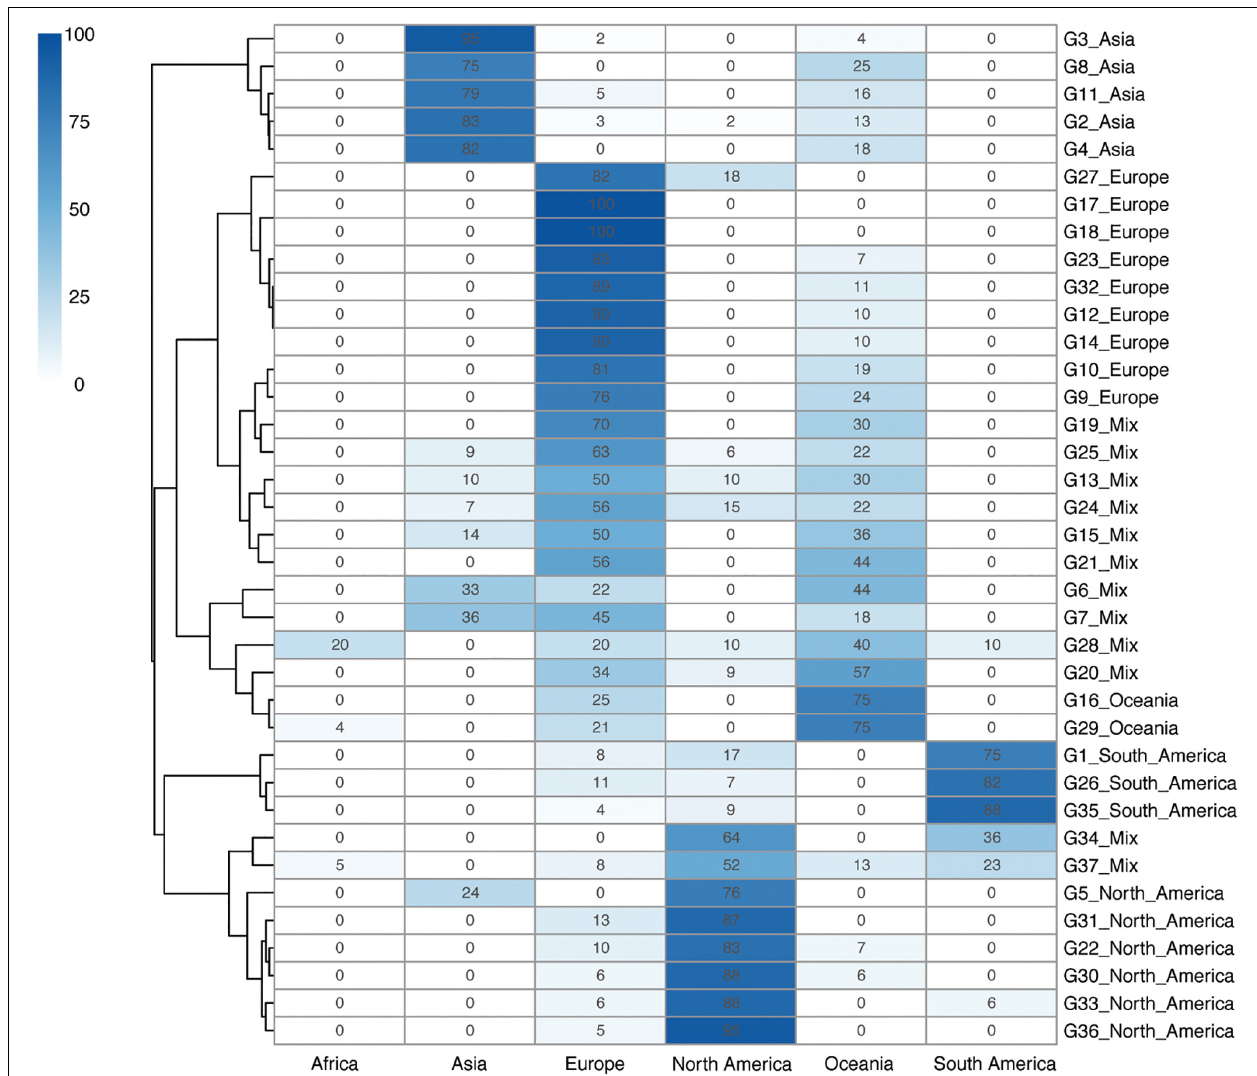
FIGURE 2 | Geographical clustering of H. pylori continent clades. The number in each cube represents the percentage of unique isolates sourced from each of the continents. A total number of 37 continent-level groups were defined. The deeper the color, the higher the percentage of the isolates in that continent level of clade groups. A phylogenetic tree is also shown on the left side of the table. Background information on the isolates is provided in Supplementary Table 1